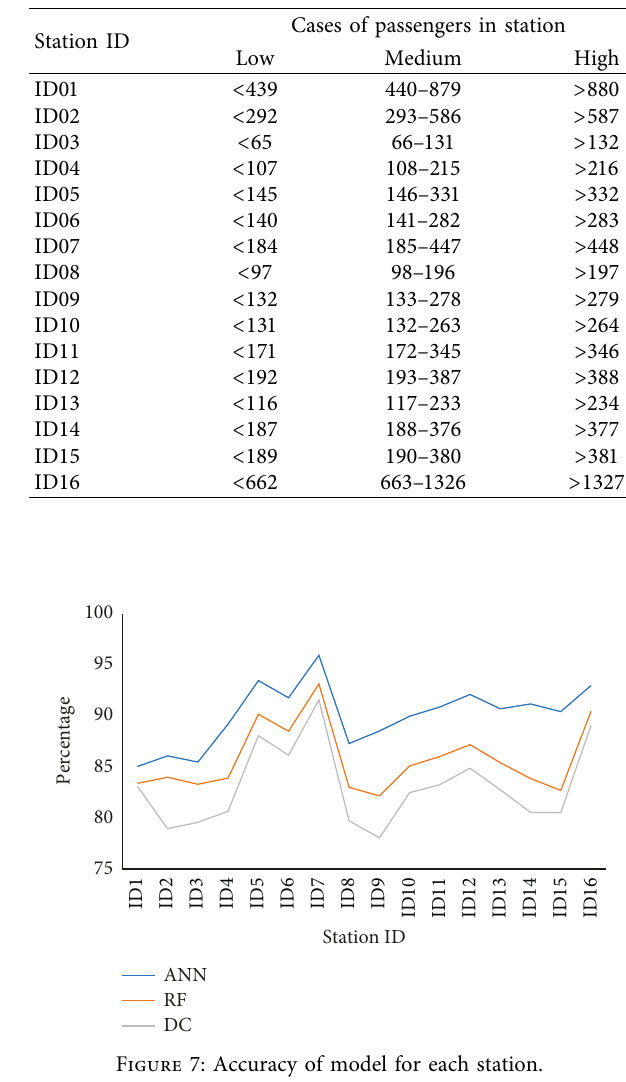
Figure 6: Confusion matrix table of decision tree. Table 16: Confusion matrix of decision tree model. Table 18: Performance of model with rain data.